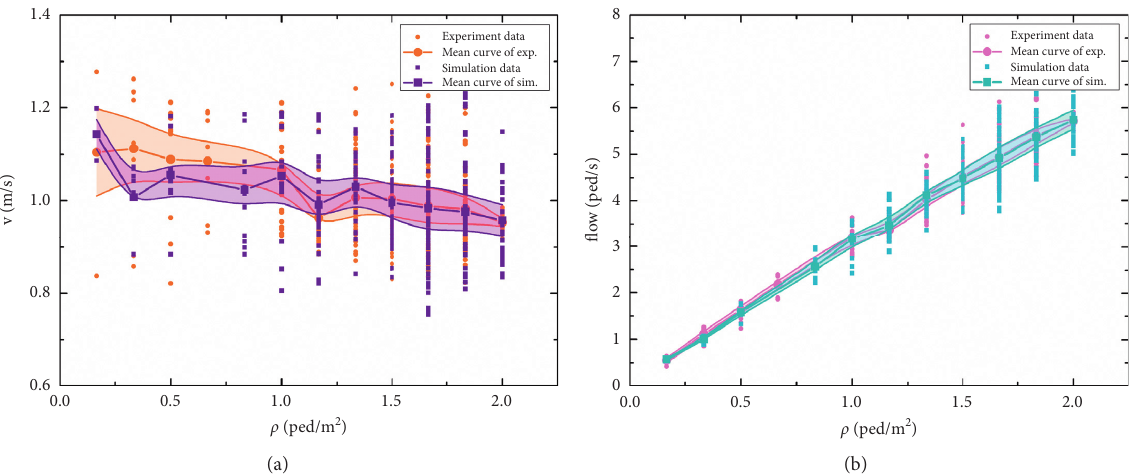
Experiment data Mean curve of exp. Simulation data Mean curve of sim.